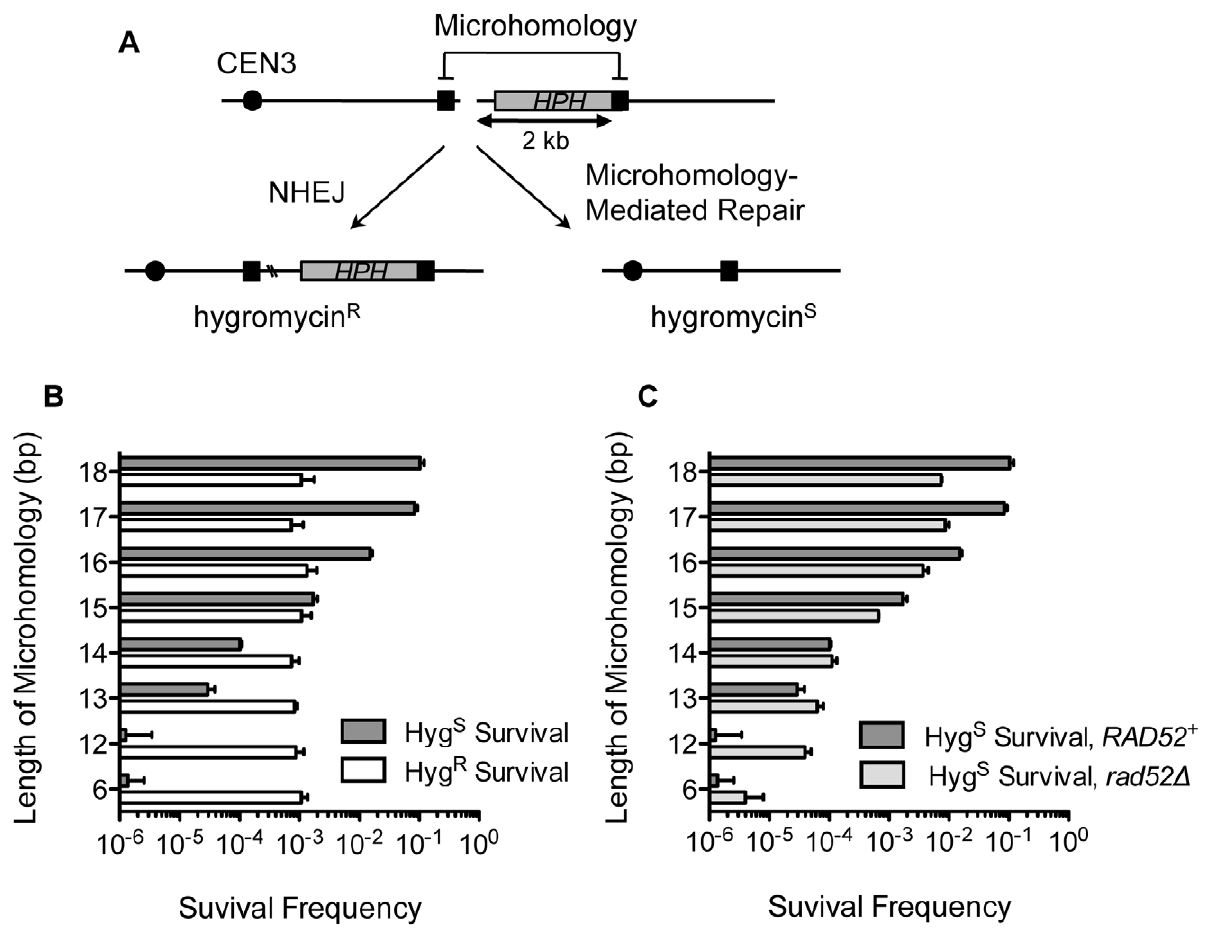
Figure 1. MHMR frequency increases 10-fold per nucleotide length from 12 bp to 17 bp. (A) A diagram of the genetic system used to distinguish microhomology-mediated repair from NHEJ-mediated repair. HPH represents the hygromycin B phosphotransferase gene that confers resistance to hygromycin treatment. The locations of HO cut site, microhomology, and centromere are shown. Two repair outcomes are distinguishable based on the sensitivity to hygromycin. Repair by NHEJ is shown by double crossing lines at the break site. (B) Graph showing survival frequency 6 S.D. using the microhomology (Hyg s ) and by NHEJ (Hyg R ). Survival frequency was calculated by dividing the number of colonies surviving on the YEP-galactose plates by the number of colonies surviving on the YEPD plates. The results are the average of three independent experiments. (C) Survival frequency using the microhomology (Hyg s ) is shown in wild type and rad52 D . Survival frequency was calculated as shown in Figure 1B. The results are the average of three independent experiments 6